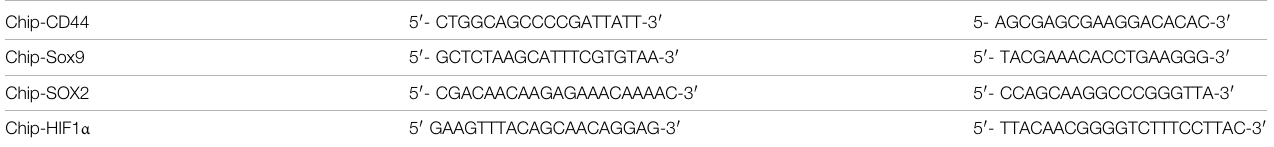
TABLE 2 | List of primers for CHIP-q PCR.